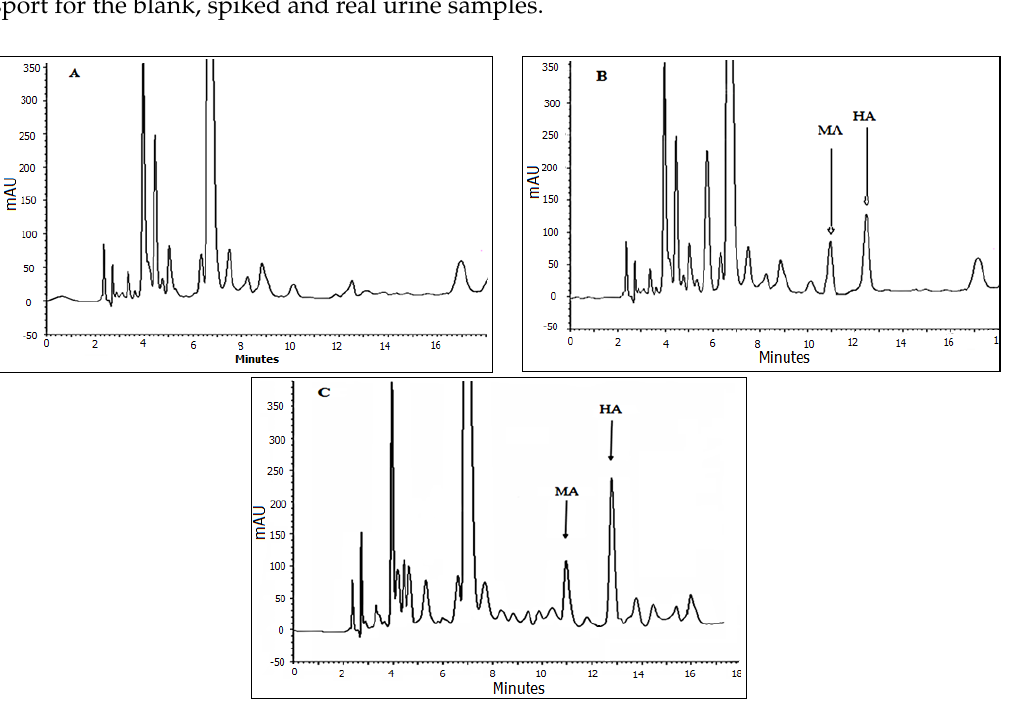
Figure 5. HPLC chromatograms of HA and MA after extraction under the optimized conditions as described in the text. ( A ) Blank urine sample from a person not exposed to benzene source; ( B ) spiked urine sample of the metabolites, at the concentration of 0.3 for ttMA and 1.5 µg·mL −1 for MA and HA; and ( C ) real sample from a person exposed to organic solvent source (petrol station worker).